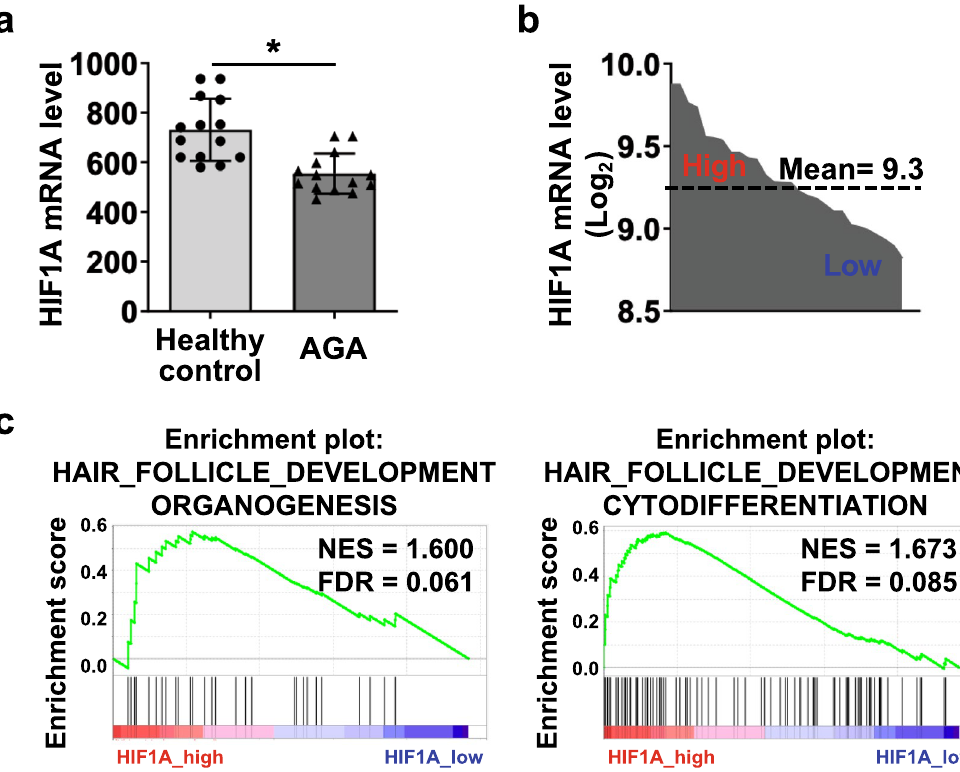
Figure 1. HIF1A is highly expressed in healthy scalp tissues, and its levels are positively correlated with hair function-related genes. (a) Linear HIF1A mRNA expression levels in healthy scalp tissues (healthy control, n = 14) and androgenetic alopecia scalp tissues (AGA, n = 14), which were collected from the GEO database (GSE90594). The results represent the means and standard error of the mean (SEM). * P < 0.05. (b) High- and low-HIF1A groups were categorized based on the mean value of log 2 transformed HIF1A mRNA level (high, n = 12; low, n = 16, mean = 9.3). (c) Representative gene set enrichment analysis (GSEA) plots of the high- and low-HIF1A